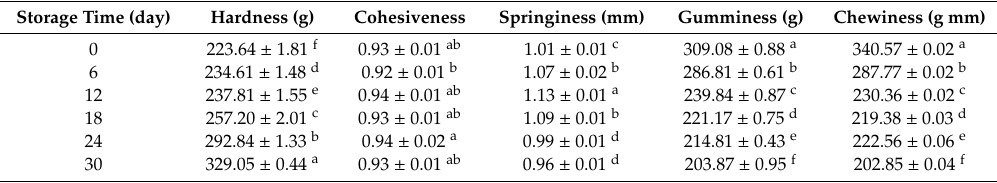
Table 3. Texture profile analysis of Chiba tofu gels with di ff erent storage times.